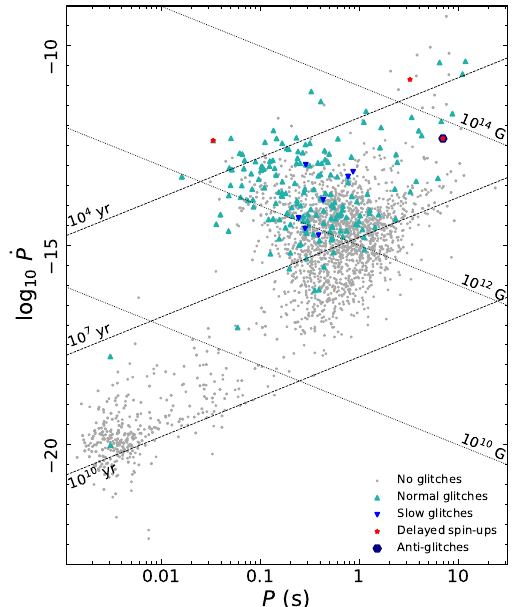
Figure 3. Period–period-derivative ( P − ˙ P ) diagram showing the pulsars for which glitch is detected based on the ATNF Pulsar Catalogue [31]. The various sub-classes of glitching pulsars are represented by the markers in the